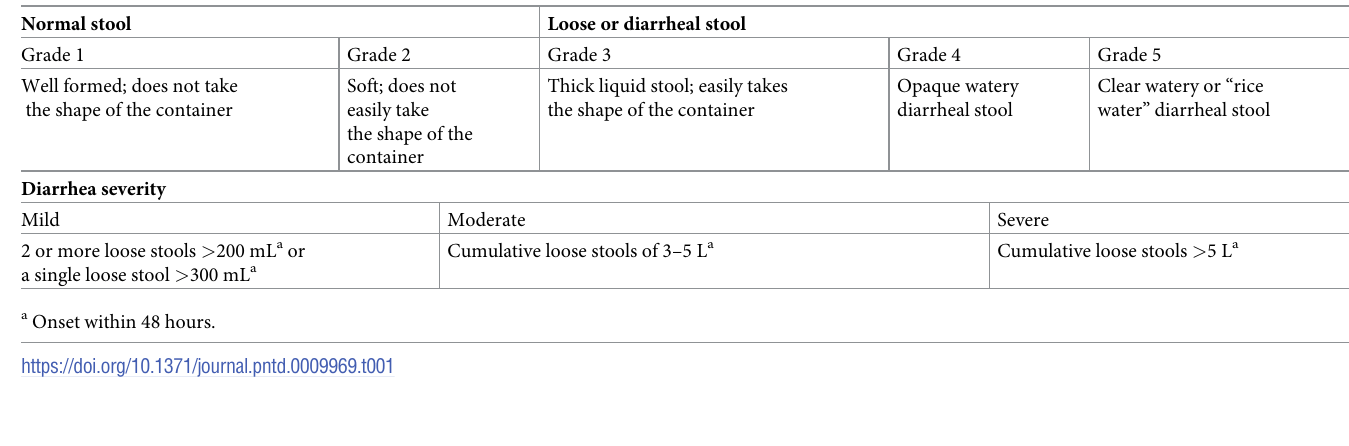
Table 1. Grading of stool consistency and diarrhea